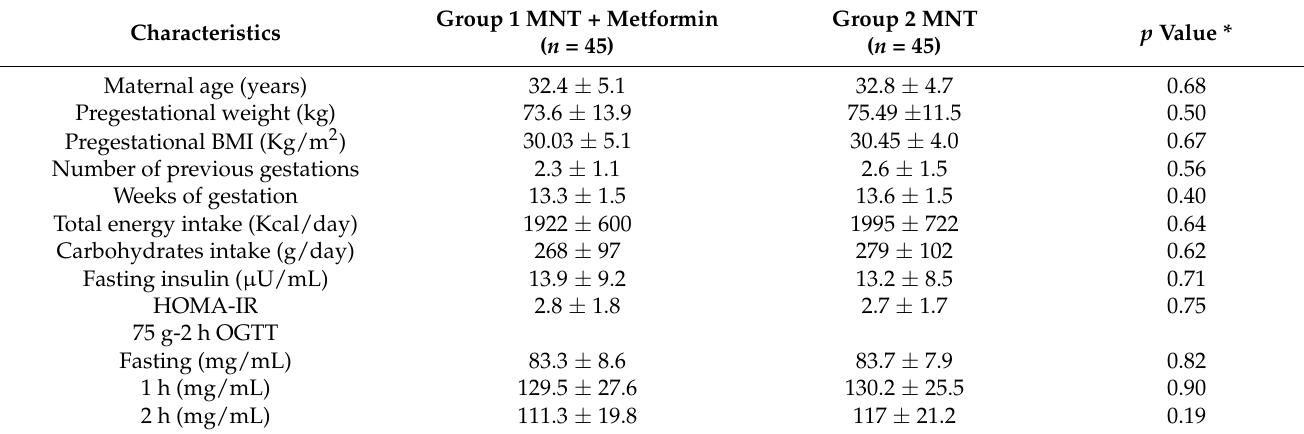
Figure 1. Flow diagram of participants included in the study. OGTT = oral glucose tolerance test MNT = medical nutrition therapy, MET = metformin, GDM = gestational diabetes mellitus. Table 3. Baseline characteristics of participants at admission to the